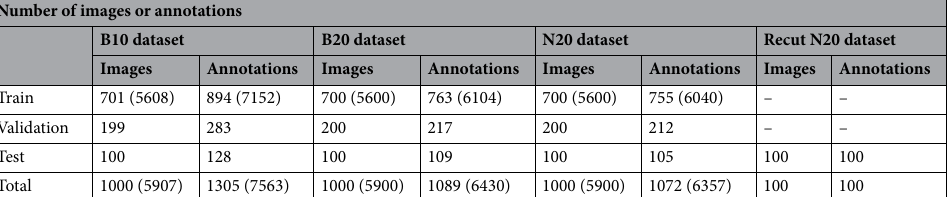
Number of images or